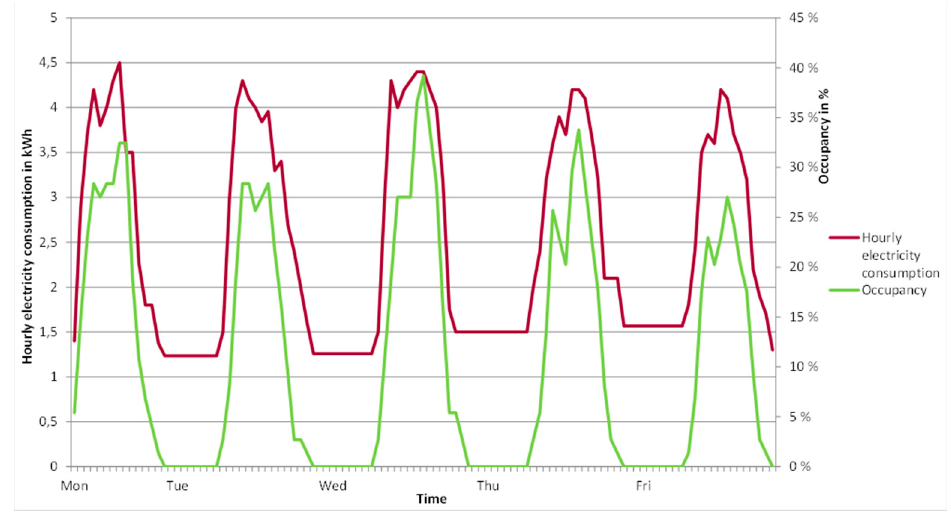
Figure 6. Effect of occupancy on people-related electricity consumption based on monitoring.